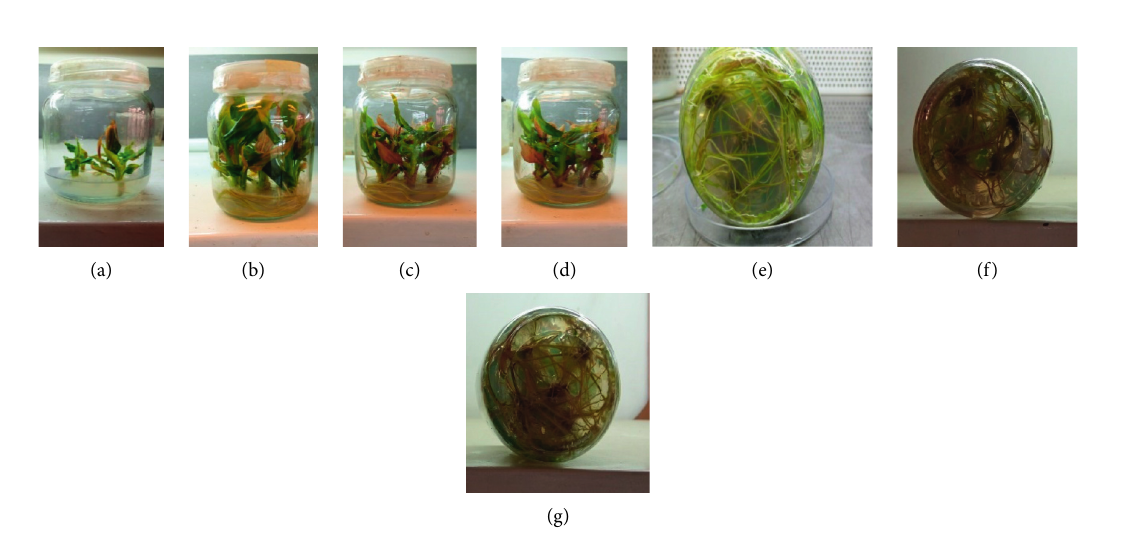
Figure 4: In vitro elongation and rooting of A. corrorima : (a) shoots cultured on rooting medium; (b) elongated plantlets on the 1/2 MS medium containing 0.75mg/l IBA after five weeks; (c) elongated plantlets on the 1/2 MS medium containing 0.5mg/l IAA after five weeks; (d) elongated plantlets on the 1/2 MS medium containing 0.75mg/l NAA after five weeks; (e) roots developed on the 1/2 MS medium containing 0.75 mg/l IBA; (f) roots developed on the 1/2 MS medium containing 0.5mg/l IAA; (g) roots developed on the 1/2 MS medium containing 0.75mg/l NAA. Bars �